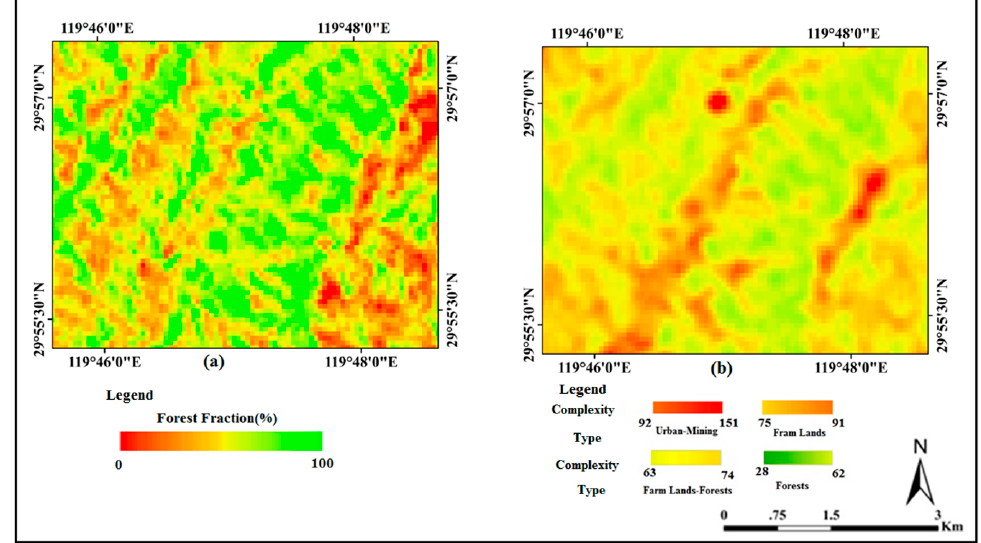
Figure 8. Maps of: ( a ) Forest Fraction using Landsat MSS based on SMA; and ( b ) land cover in forested regions using Landsat MSS and CORONA without using Kriging.